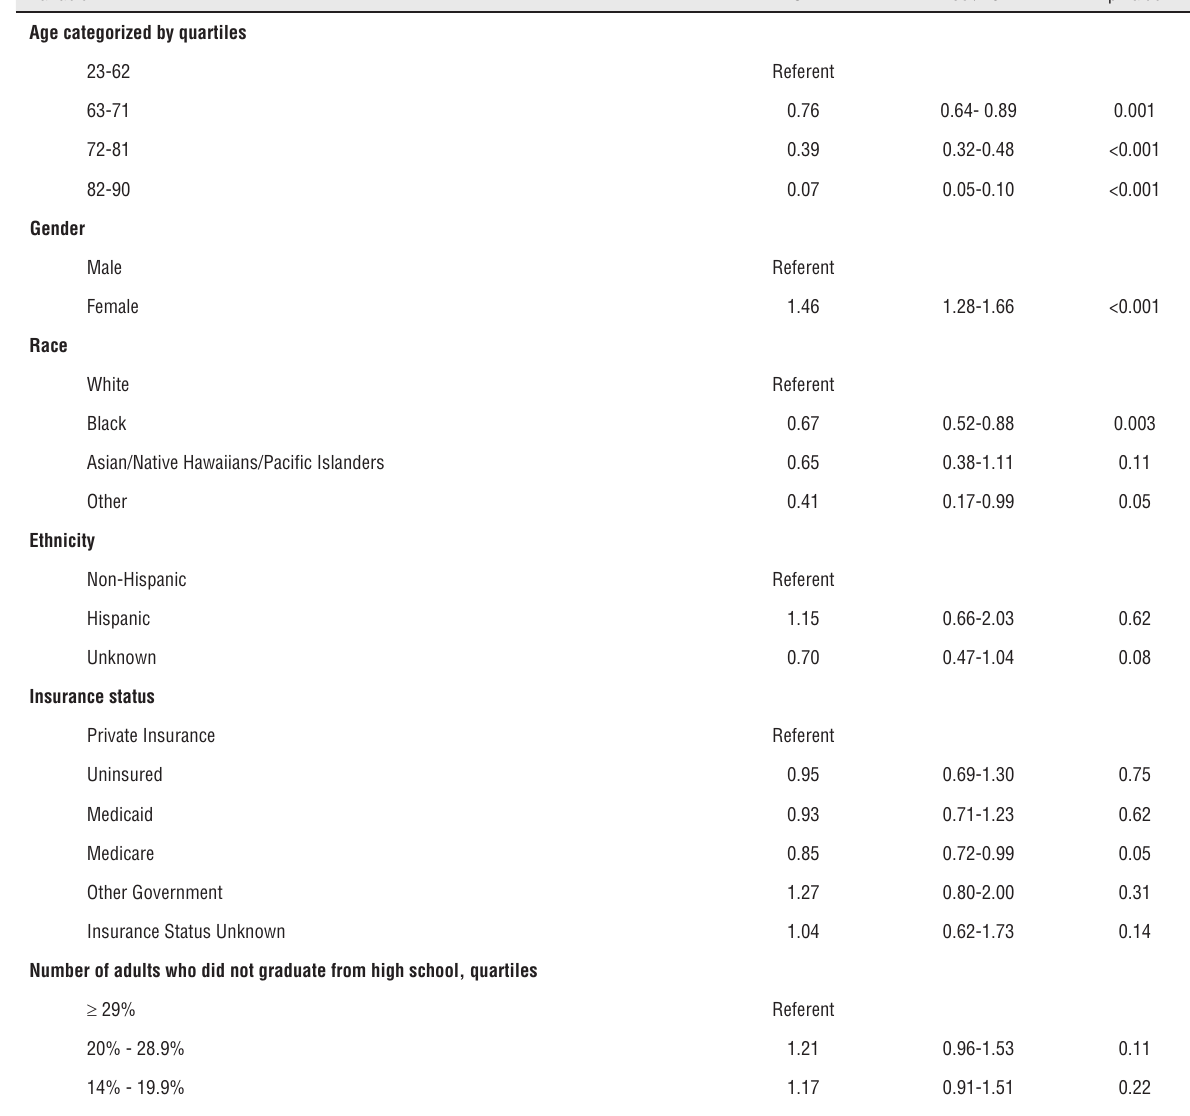
Table 3 - Associations of clinical features with receipt of NAC for patients with MIBC and Charlson Comorbidity Index 0.